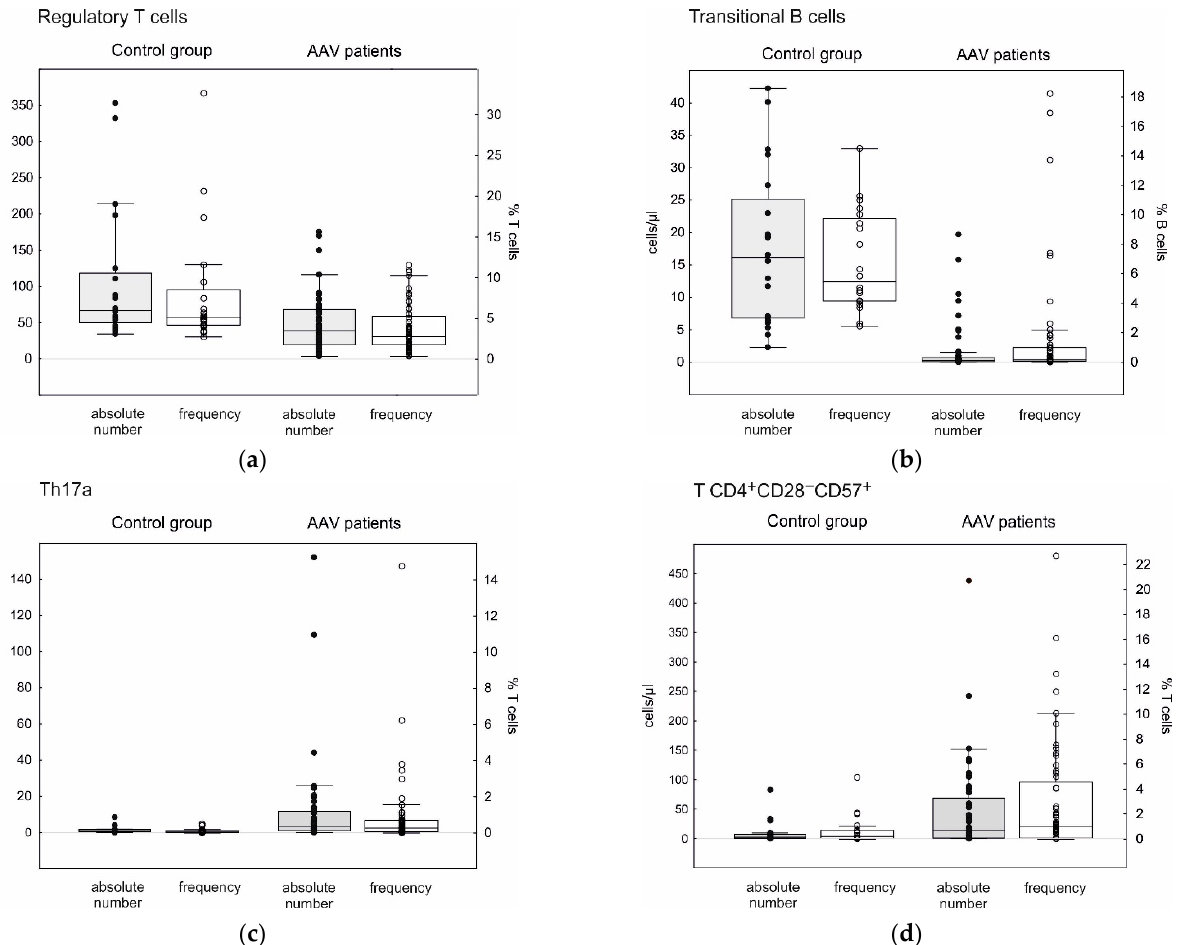
Figure 3. Absolute counts and frequency of selected peripheral blood lymphocyte subpopulations. Box—IQR, line—median, whiskers—non-outliers range, ○ —raw frequency data, ● —raw absolute count data. ( a ) Regulatory T cells: absolute count, AAV vs. HC—40, 19–71 cells/µL vs. 67, 50–118 cells/µL, p < 0.001; frequency, AAV vs. HC—2.8, 1.8–5.5% vs. 5.1,